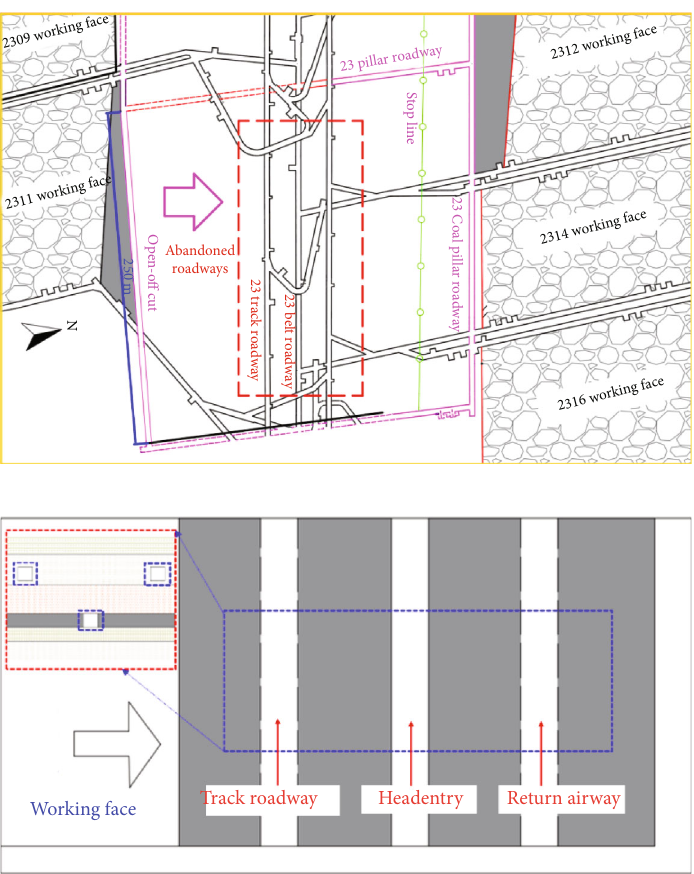
Figure 1: Layout of the no. 23 coal pillar working